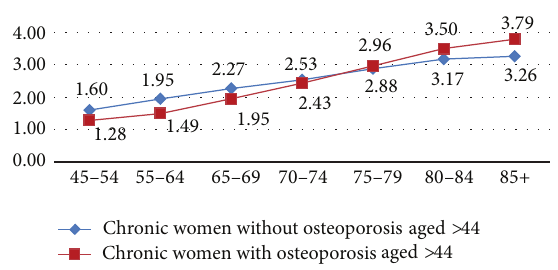
Figure 1: Average of chronic conditions in women with and without osteoporosis by age group.